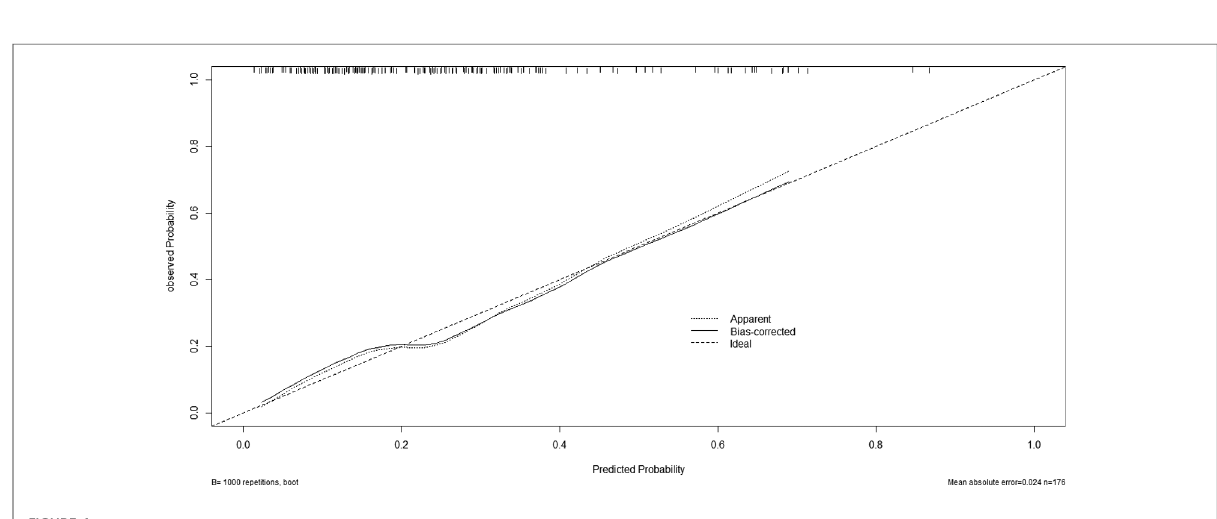
FIGURE 4 Calibration curve of the predictive